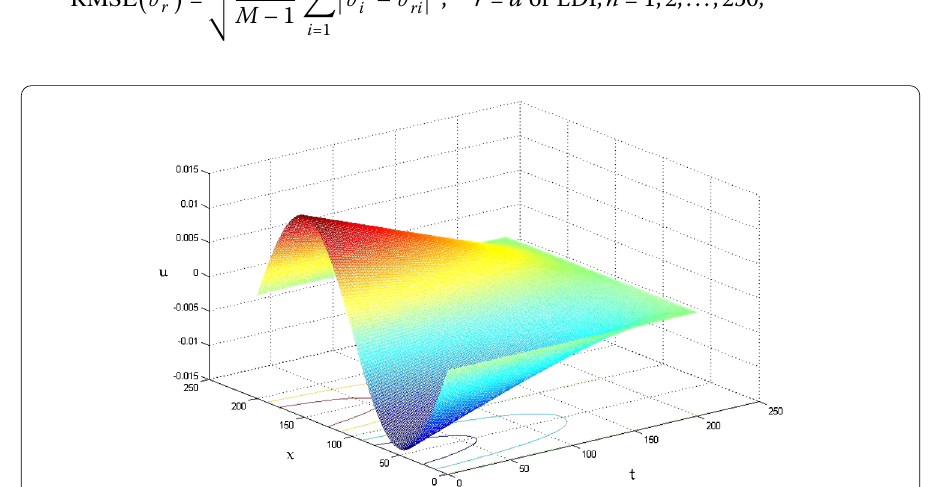
Figure 4 The OCNFDE solutions when 0 ≤ t ≤ 2.5 and 0 ≤ x ≤